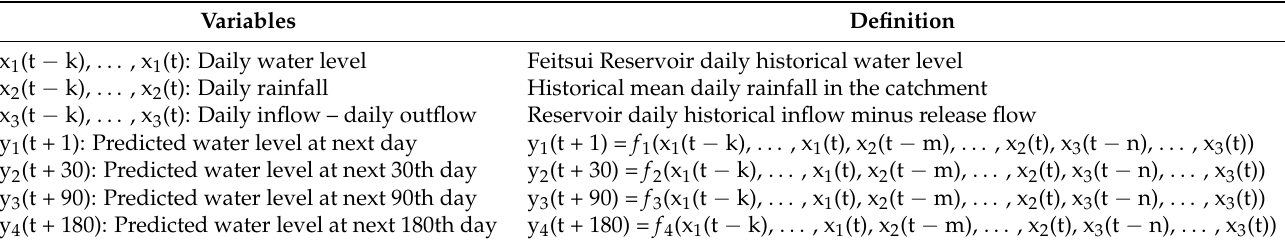
Table 1. Variable description of the Feitsui Reservoir.